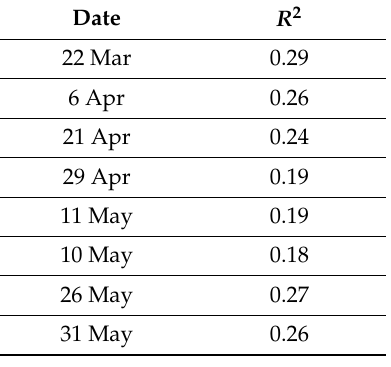
Table 3. Correlation between yield and NDVI at any time of NDVI measurement plotted over all of the Figure 5. NDVI time series analysis, considering the three vigor classes as identified in the S2 image 229 168 plots. of March 22 nd (I: NDVI ≤ 0.68; II: 0.68 < NDVI ≤ 0.79; III: NDVI > 0.79), for the three N fertilization 230 treatments: 1) Flat-N (standard rate of 120 kg N ha − 1 ); 2) Var-N-low (variable rate from 60 to 120 kg N 231 ha − 1 ); 3) Var-N-high (variable rate from 90 to 150 kg N ha − 1 ). 232